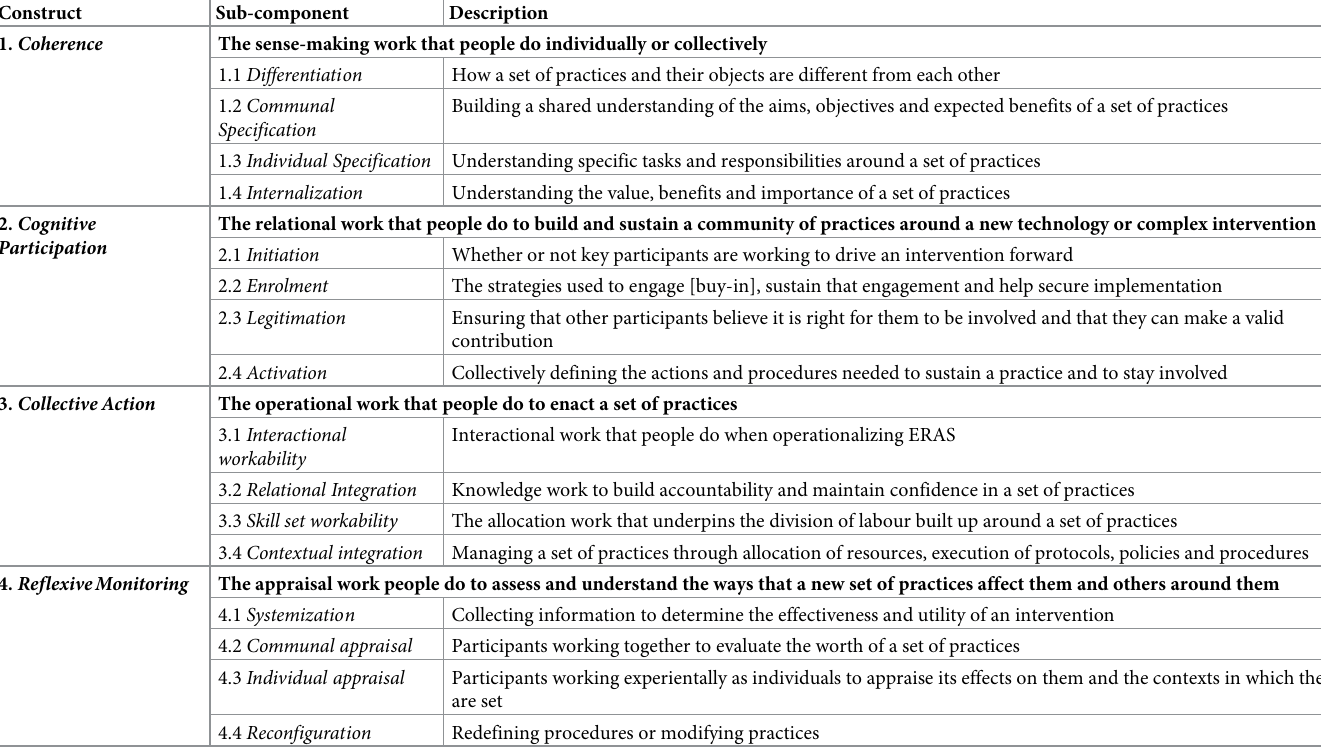
Table 1. Normalization Process